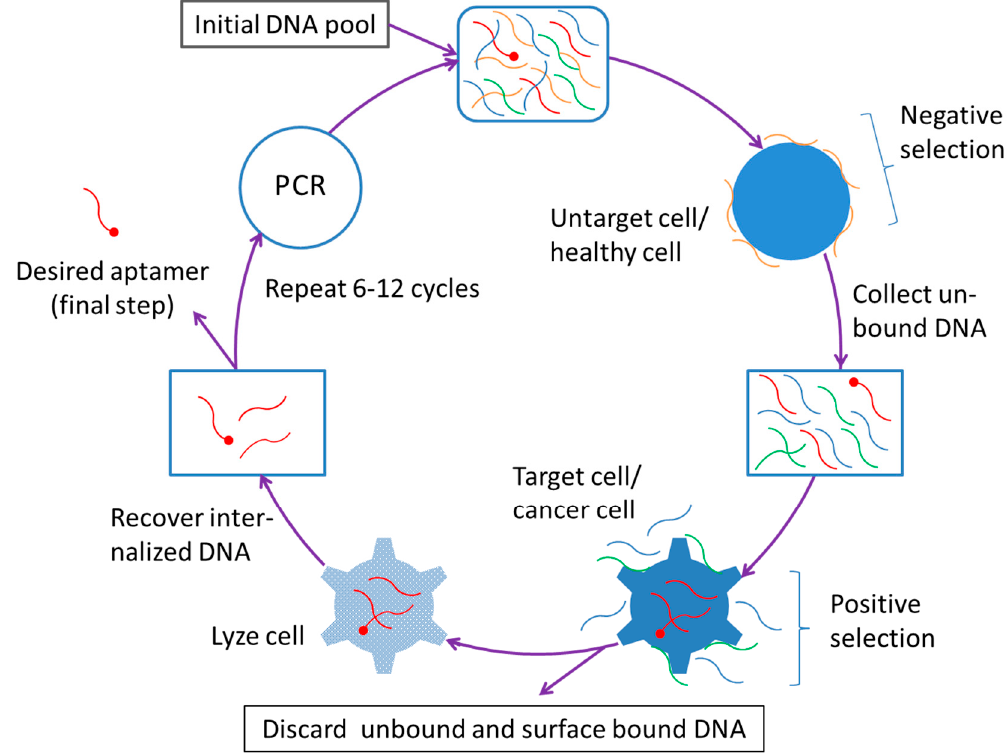
Figure 1. Selection procedure of cell-internalizing DNA aptamer using cell-SELEX.